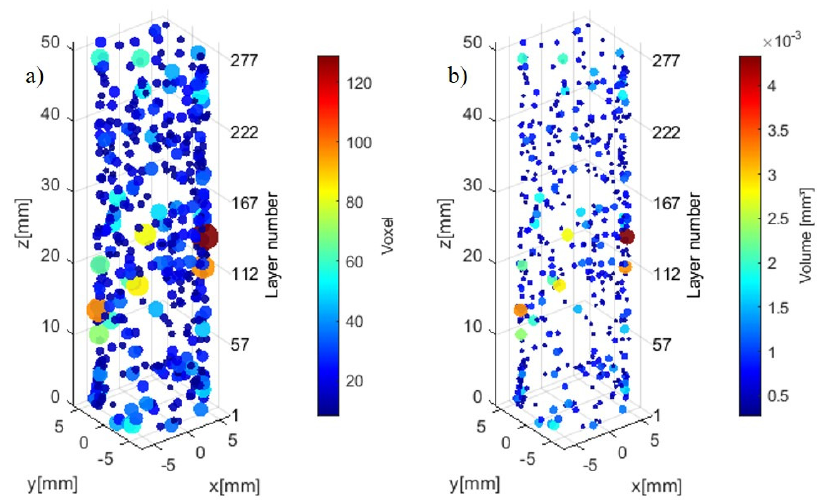
Figure 6. ( a ) Inter-layer low-density identification (voxel scale 0.03228 mm) and ( b ) Volumetric mea-